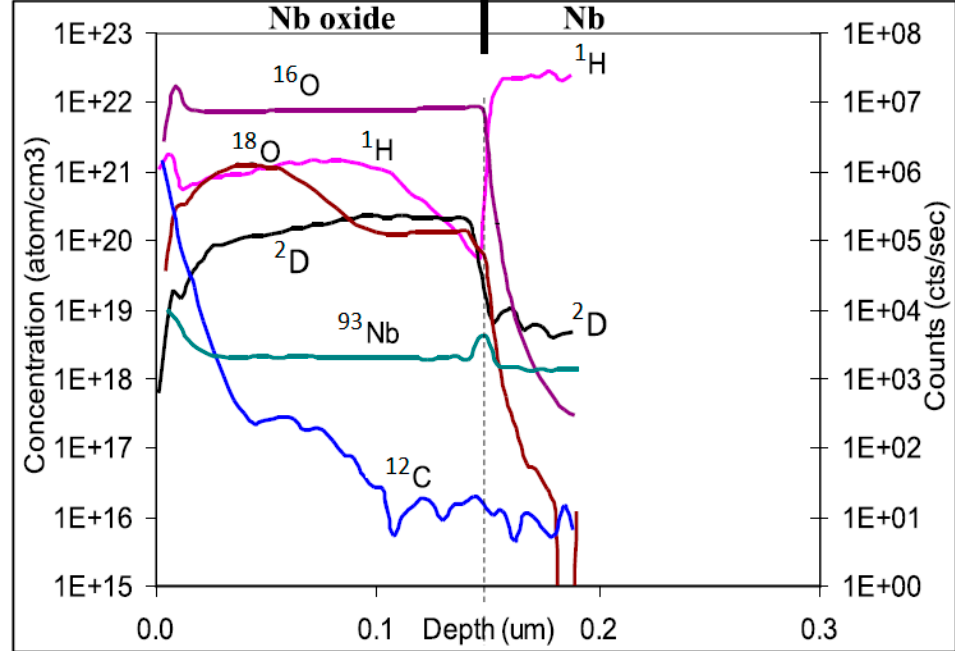
Figure 8. SIMS depth profile of niobium oxide on niobium after ion implantation of 1 H, 2 D, and 18 O. Adapted according to [84] with permission. Copyright 2011 John Wiley & Sons.